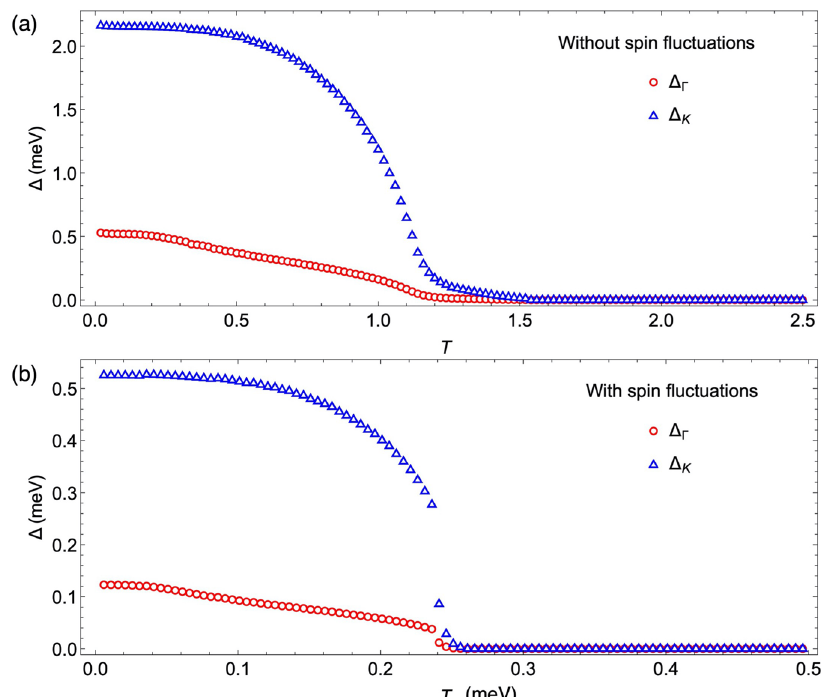
Fig. 4 Analytical solution of the two-gap BCS equations. Analytical evaluation of the pairing interaction, by fi tting the two-gap BCS equations to that of our fi rst-principles calculations including ( a ) electron – phonon interaction and b both electron – phonon interaction and spin- fl uctuation effects evaluated utilizing density functional theory arti fi cially stabilized by Hubbard interactions combined with spin-spiral